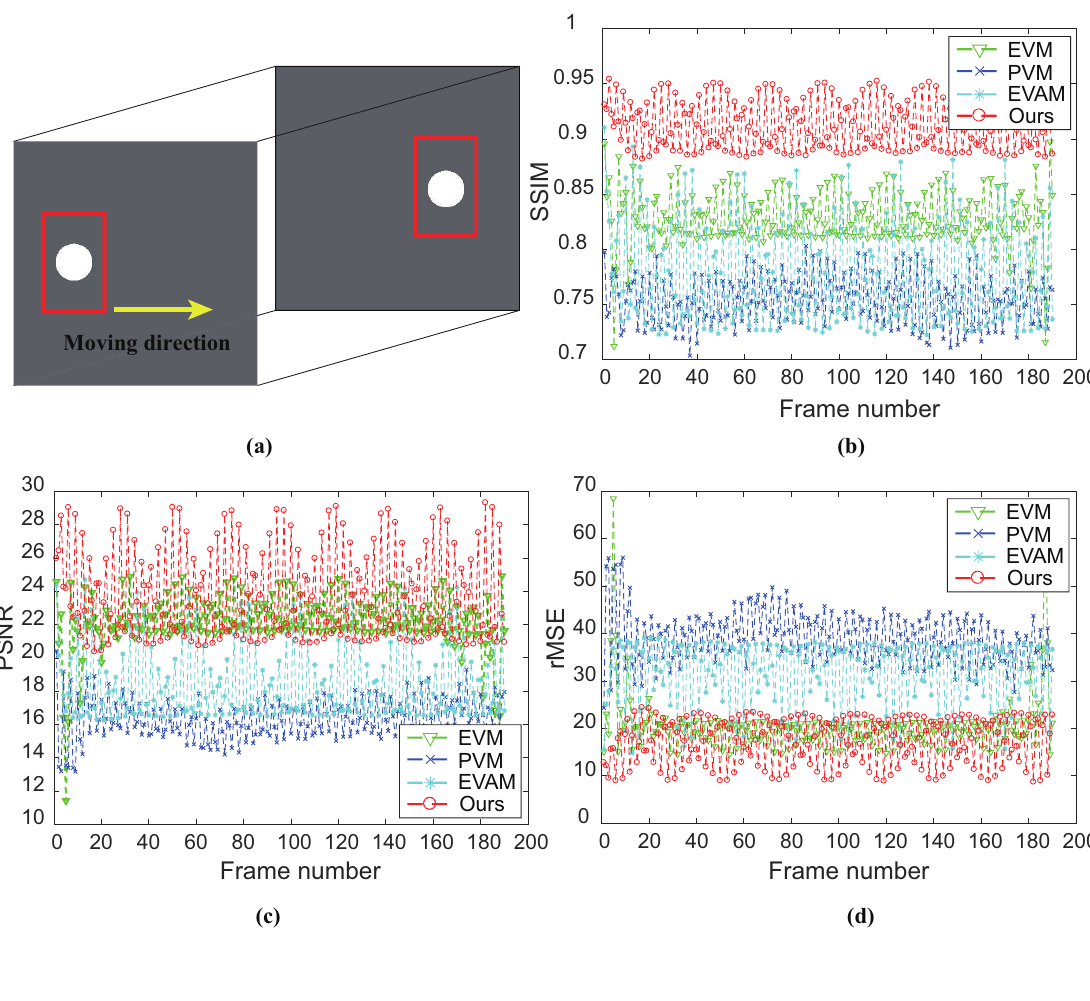
Figure 9. Quantitative assessment of different methods by means of comparing the magnification results of SynVideo1 with ground-truth. ( a ) Frames from SynVideo1. ( b ) SSIM with ground-truth for each magnified frame. The closer that this value is to 1, the better performance of the algorithm is. ( c , d ) PSNR and rMSE with ground-truth for each magnified frame. The larger the PSNR value and the smaller the rMSE value are, the better the performances are. Here, the metrics are computed for only sites included in the red rectangle (see ( a